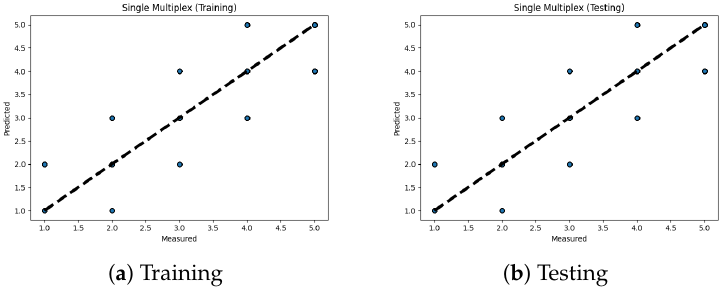
Figure 24. TAWSEEM: prediction errors (single multiplex